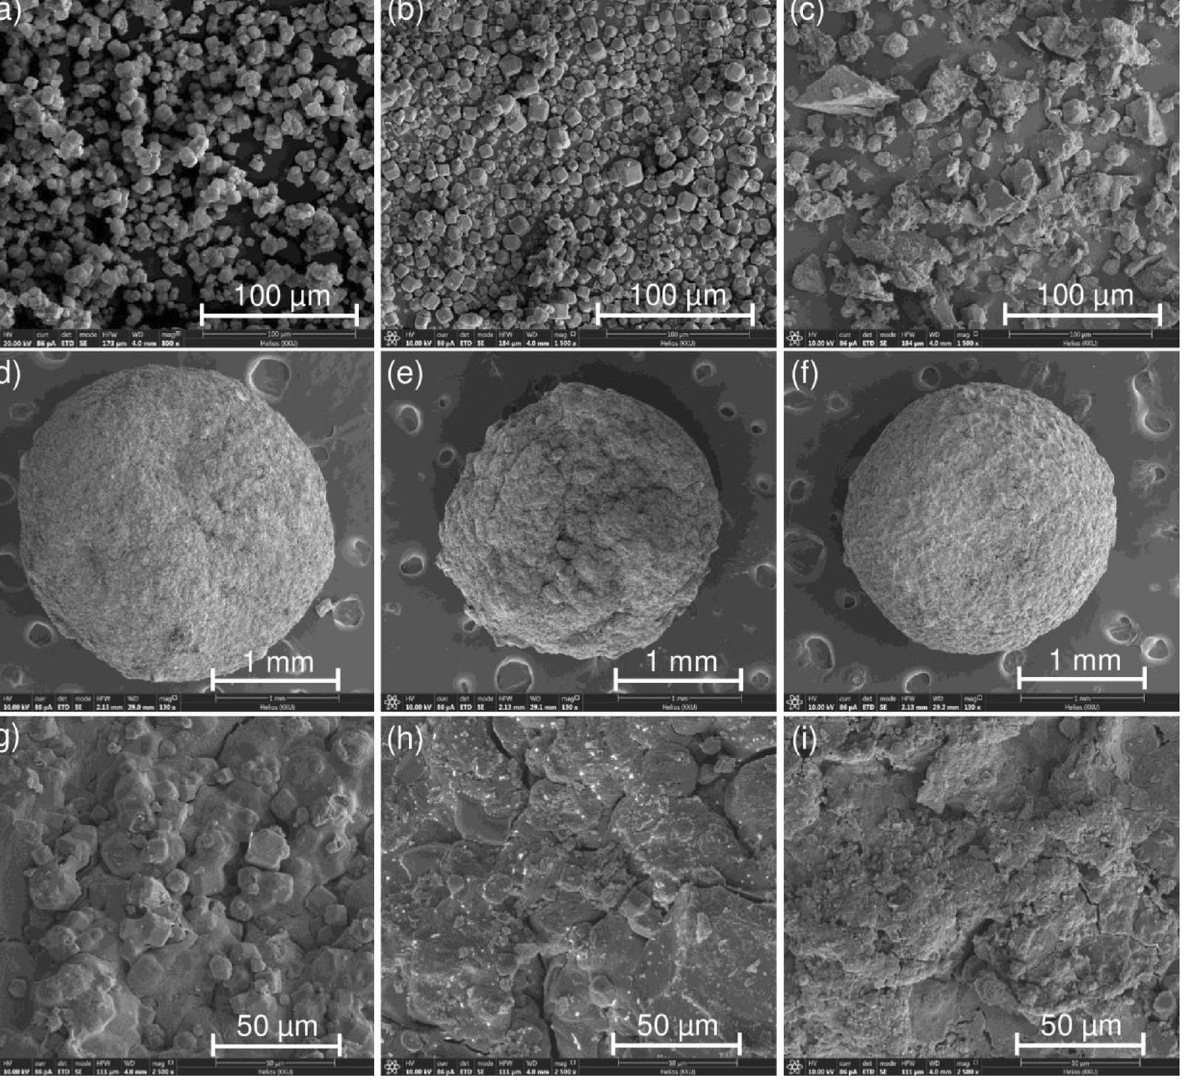
Figure 3. FESEM-FIB micrographs of ( a ) zeolite A standard (STD), ( b ) zeolite A sugarcane bagasse fly ash powder (ZB), ( c ) zeolite A sugarcane bagasse fly ash powder mixed iron(III) oxide-hydroxide (ZBF), ( d , g ) zeolite A sugarcane bagasse fly ash beads (ZBB), ( e , h ) zeolite A sugarcane bagasse fly ash powder mixed iron(III) oxide-hydroxide beads (ZBFB), and ( f , i ) zeolite A sugarcane bagasse fly ash beads coated iron(III) oxide-hydroxide